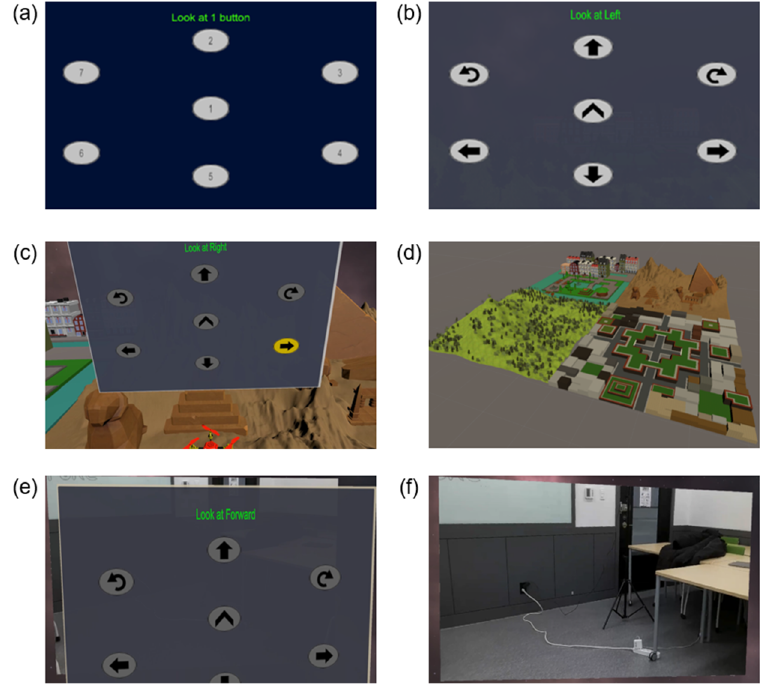
Figure 3. UI of the system developed. ( a ) Button interface for the training session. ( b ) Button interface for the online session. ( c ) VR content to control a virtual drone. Desert map is shown. ( d ) All four maps (park, dessert, maze, and forest). ( e ) AR contents to control a real drone. Button interface is shown. ( f ) A real video in HMD streamed from the drone.